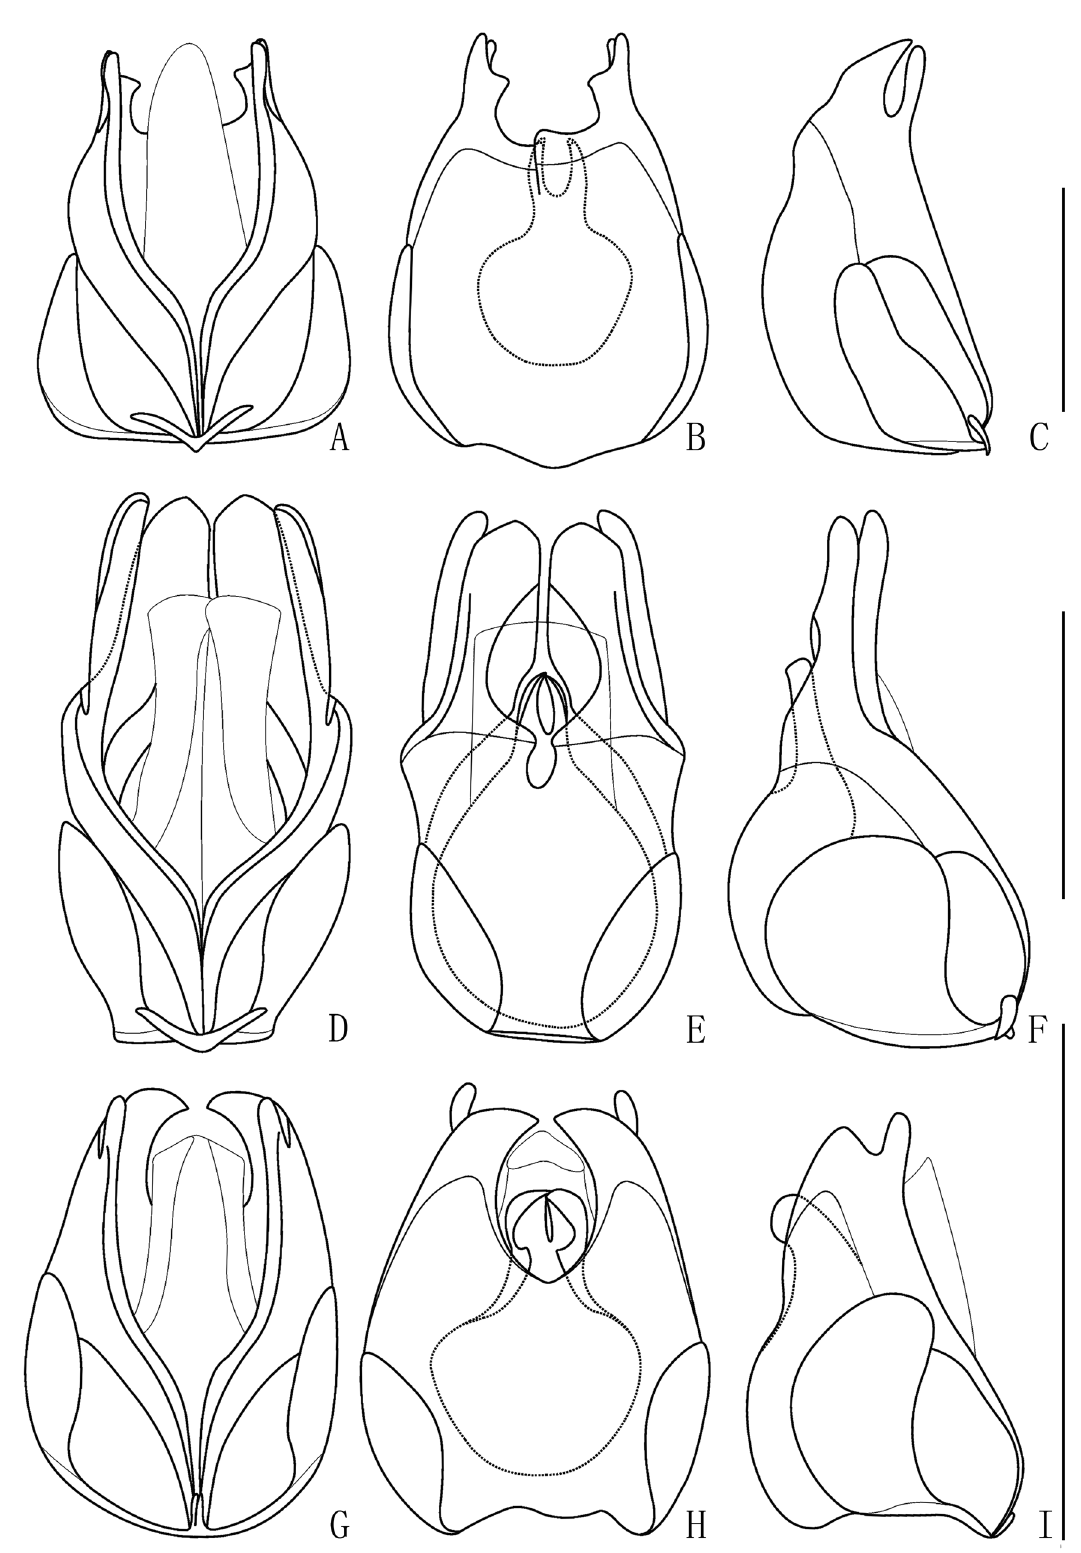
Fig. 5. Aedeagus (A, D, G = ventral view; B, E, H = dorsal view; C, F, I = lateral view). A‒C . Steno- themus fukienensis Wittmer, 1974 (IZAS, IOZ(E)1659634). D‒F . S. kuatunensis Wittmer, 1979 (IZAS). G‒I . S . chinensis (Wittmer, 1982) comb. nov. (IZAS, IOZ(E)1436585). Scale bars: 1.0